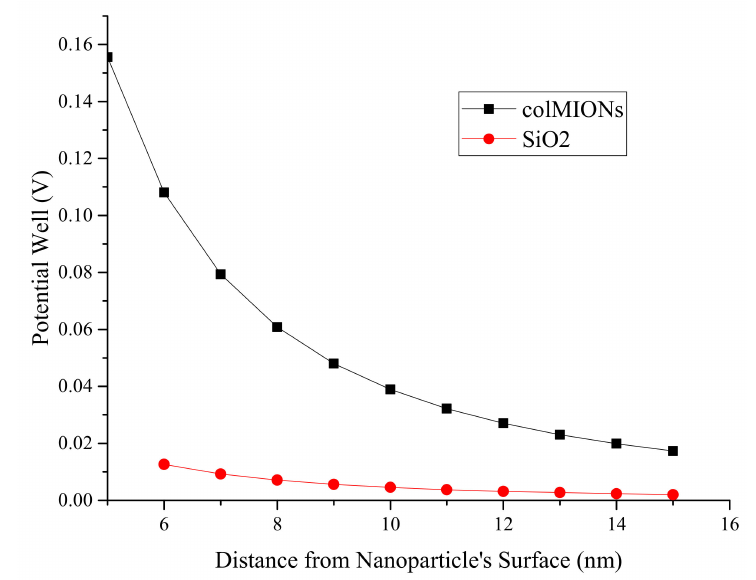
Figure 4. Potential well distribution of oleate-coated colloidal magnetic iron oxide nanocrystals (colMION) and SiO 2 nanoparticles versus the distance from the nanoparticle’s